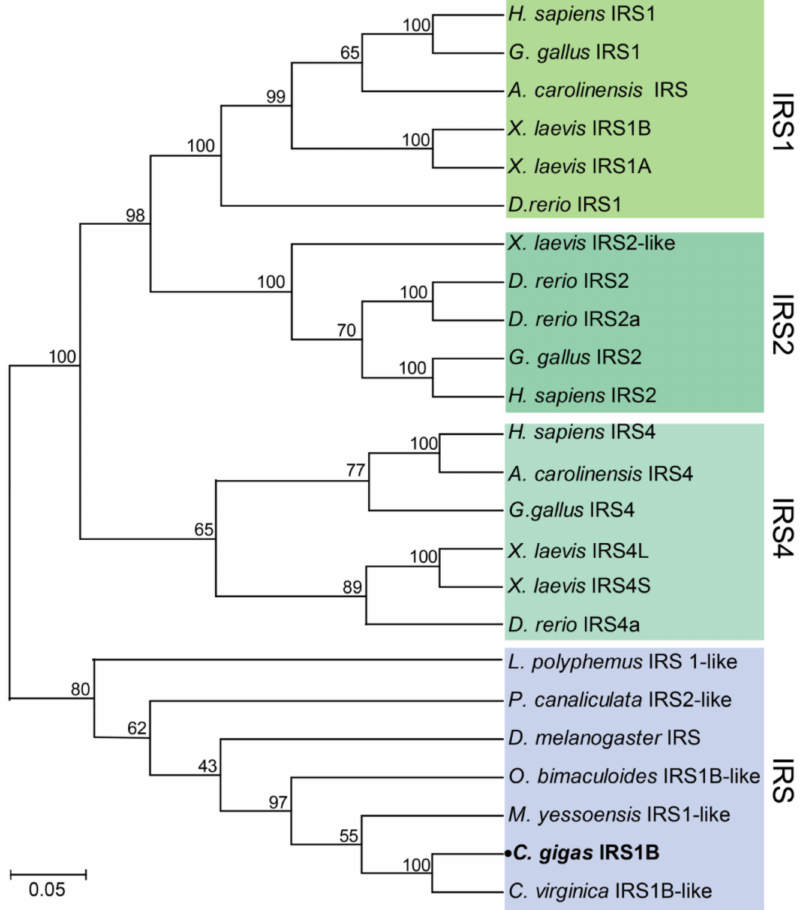
Figure 2. Phylogenetic analyses of the insulin receptor substrates. The amino acid sequences of the insulin receptor substrates from Homo sapiens , Gallus gallus , Xenopus laevis , Anolis carolinensis , Danio rerio , Drosophila melanogaster , Limulus polyphemus , Mizuhopecten yessoensis , Octopus bimaculoid , Pomacea canaliculata , Crassostrea virginica, and Crassostrea gigas were retrieved from the NCBI database. The phylogenetic tree was constructed using the neighbor-joining (NJ) approach in MEGA7. The reliability of the topological structure was tested using 1000 bootstrap